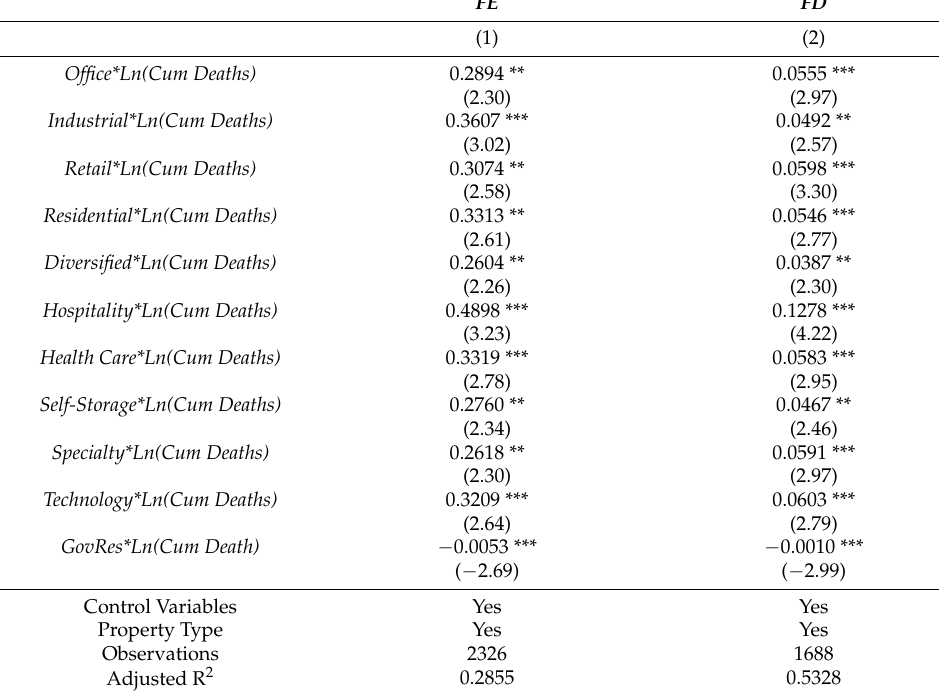
Panel B. Cumulative number of COVID-19